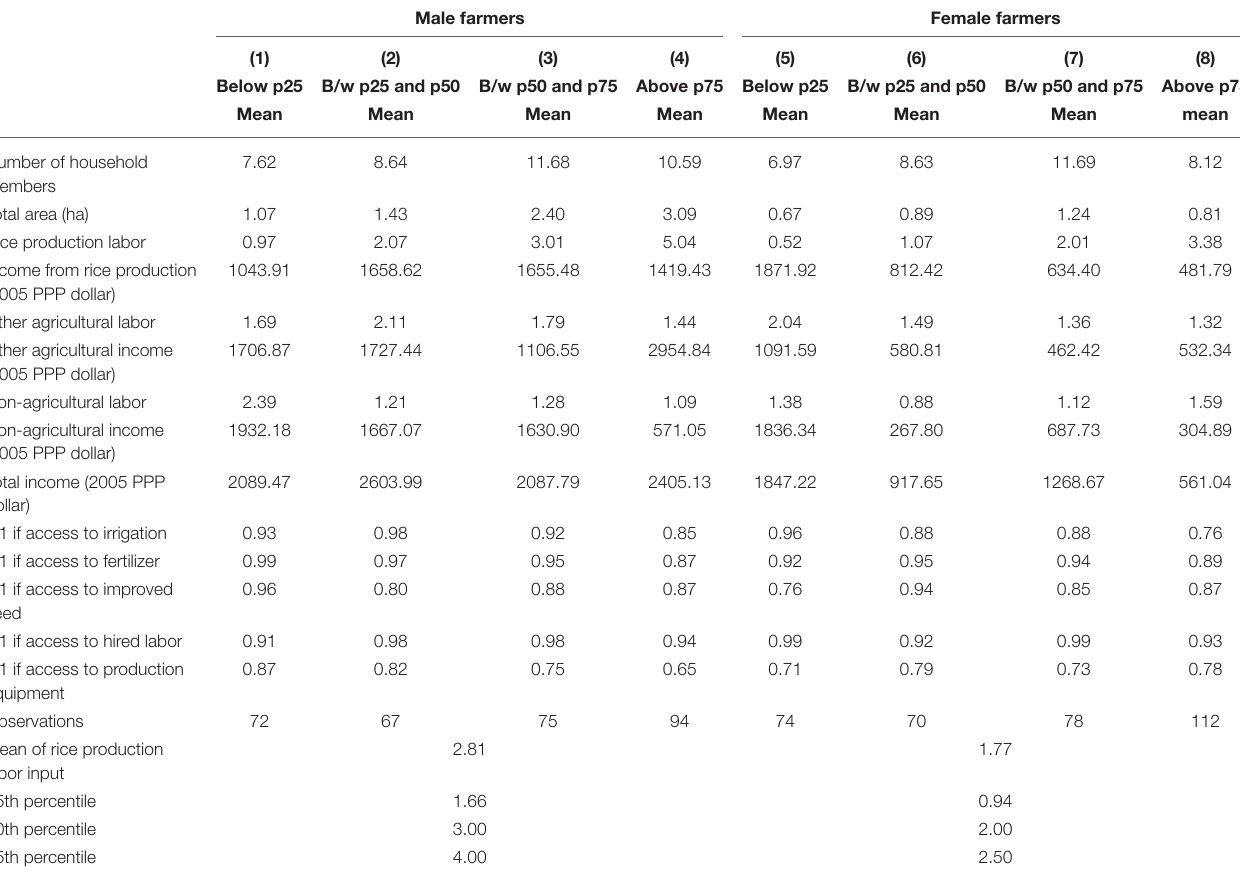
TABLE 6 | Summary statistics conditional on labor inputs for rice production in Burkina Faso, Côte d’Ivoire, Madagascar, and Sierra